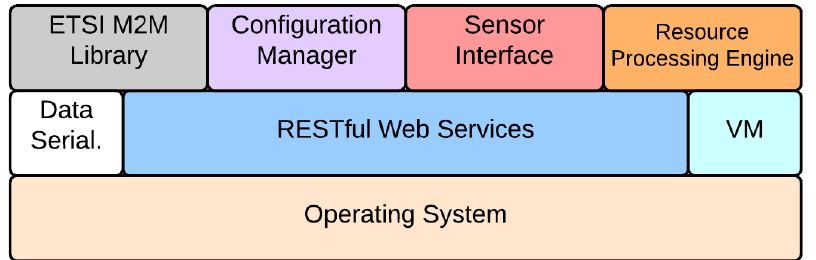
Figure 4. Middleware